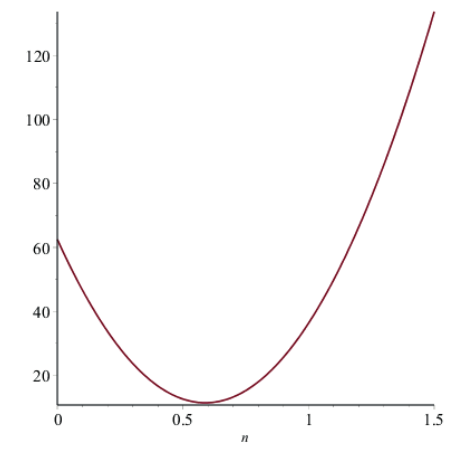
Figure 12: Plot of I ( D